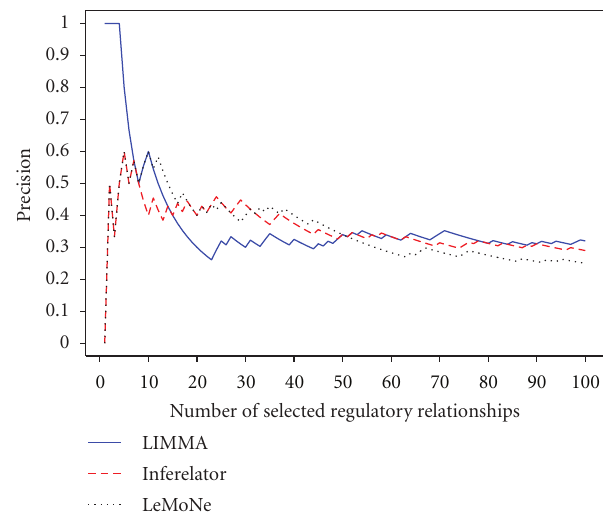
Figure 3: Comparison of precision of three candidate learning algo- rithms. For each algorithm, the figure shows the precision (8) when the top i ( i = 1,2, ... ,100) regulator-module interactions in the rank given by the algorithm are